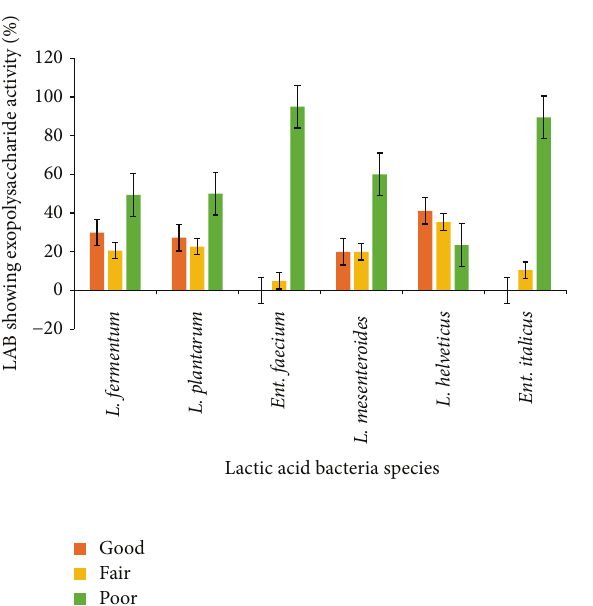
Figure 4: pH of fermenting milk with different starter cultures. Spontaneously fermented (Sp), L. fermentum (Lf), L. plantarum (Lp), L. helveticus (Lh), and L. mesenteroides (Lm), L. fermentum + L. plantarum (Lf + Lp), L. fermentum + L. helveticus (Lf + Lh), L. fermentum + L. mesenteroides (Lf + Lm), L. plantarum + L. helveticus (Lp + Lh), L. plantarum + L. mesenteroides (Lp + Lm), L. helveticus + L. mesenteroides (Lh +